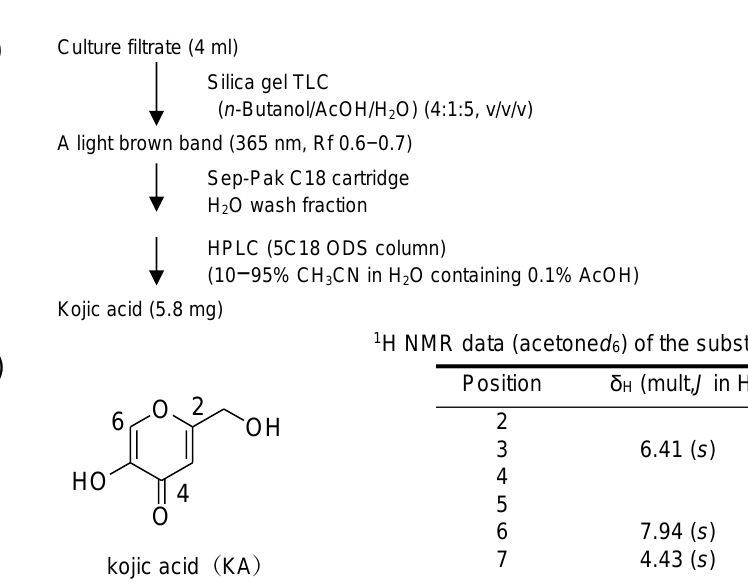
Figure 6. The purification and clarification of the structure of substance B that decreased the CTN fluorescence: ( a ) Purification steps of substance B from the culture medium of NIAH-26; ( b ) 1 H NMR data of substance B. Substance B was confirmed to be KA.